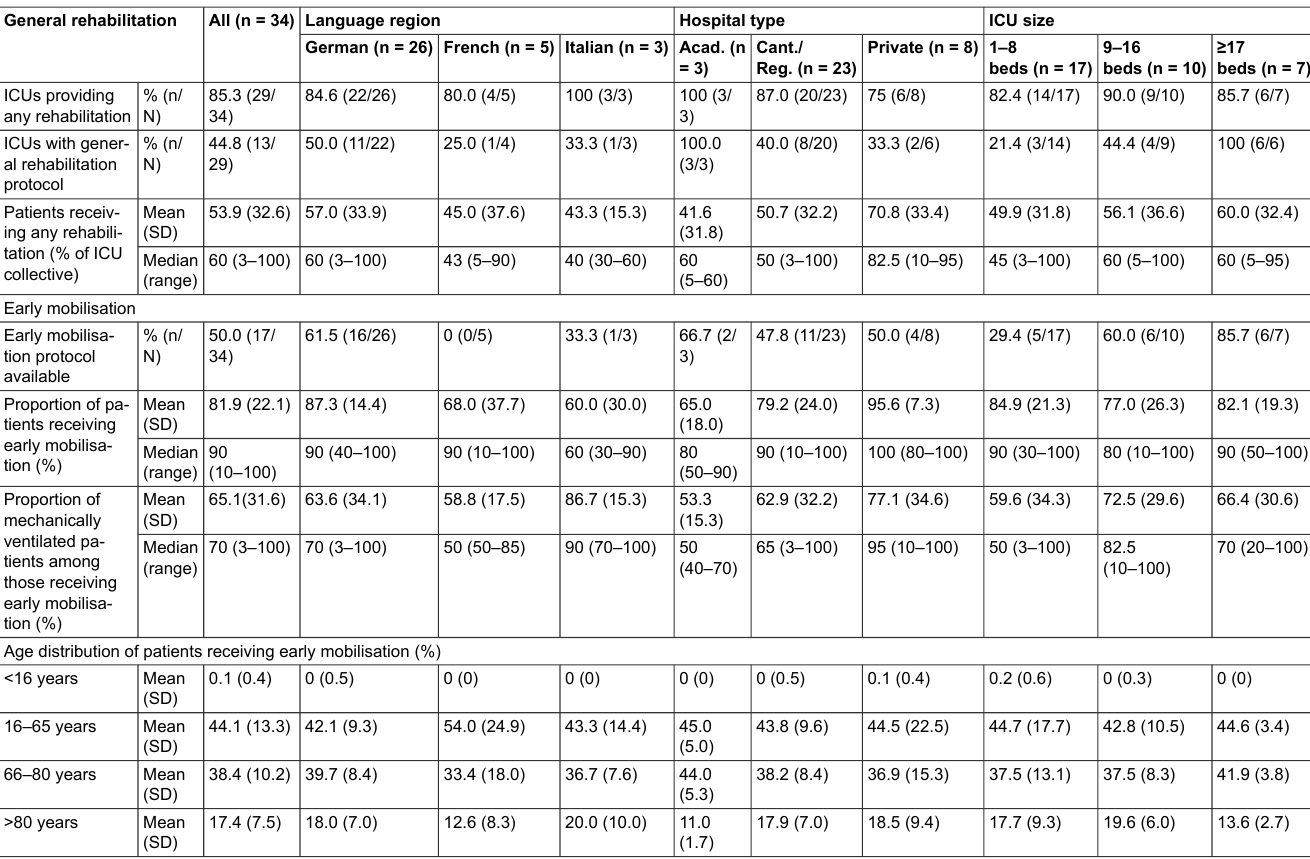
Table 2: General rehabilitation approaches and early mobilisation in participating intensive care units (ICUs caring for adults only). General